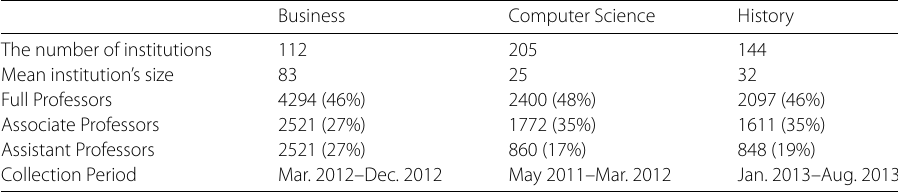
Table S1 Summary of the Hiring Networks of Three Departments. Data summary for the collected faculty hiring networks for three disciplines: Business, Computer Science, and History. The number of institutions and institution’s size regarding the faculty hiring has been preserved in five hiring